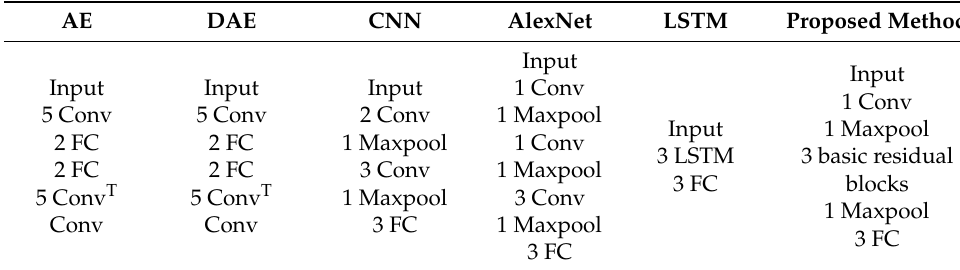
Table 3. The architecture of comparison